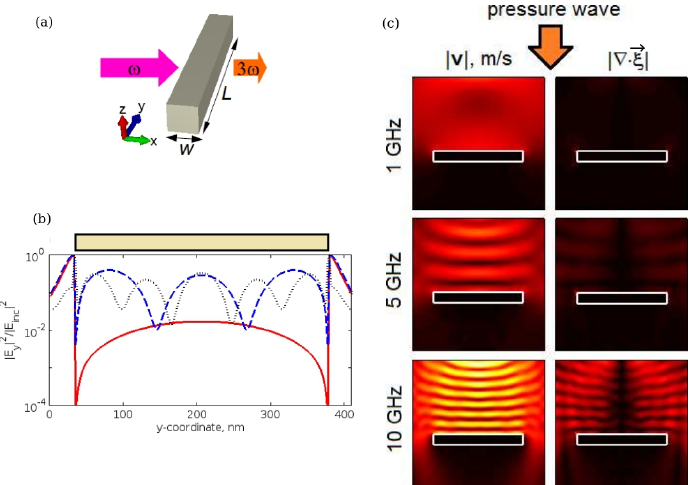
Figure 11. ( a ) Illustration of a numerical simulation configuration for investigation of the optical third harmonic generation in a 30nm × 30nm square cross-section silver nanorod immersed into water. A plane light wave polarised along the y -axis of the coordinate system is normally incident from the left. ( b ) Normalised simulated electric field intensity at the centre of the nanorod cross-section. The rectangle in the main panel schematically shows the length of the nanorod. The solid, dashed and dotted lines depict profiles of the fundamental mode, and the second and third higher-order modes, respectively. ( c ) Simulated spatial profiles of the acoustic velocity | v | (left column) and the divergence of the displacement field | ∇ · (cid:126) ζ | for the acoustic frequency 1, 5 and 10 GHz. The white rectangle shows the contour of the nanorod. The black (yellow) colour denotes zero (maximum) for the profile intensity. The direction of the incident monochromatic acoustic pressure wave is indicated by the arrow. Note that the value of | v | in front of (behind) the nanorod increases (decreases) due to the well-known pressure doubling effect [118].